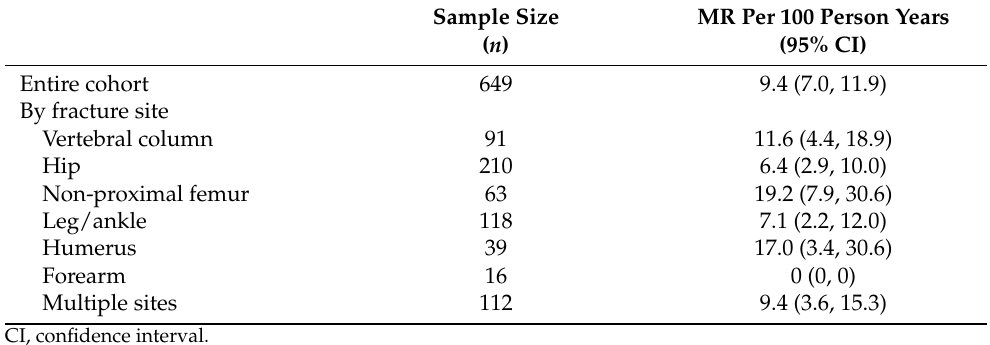
Table 4. Mortality rate (MR) within 1-year post-fracture for the entire study cohort and then by fracture site.